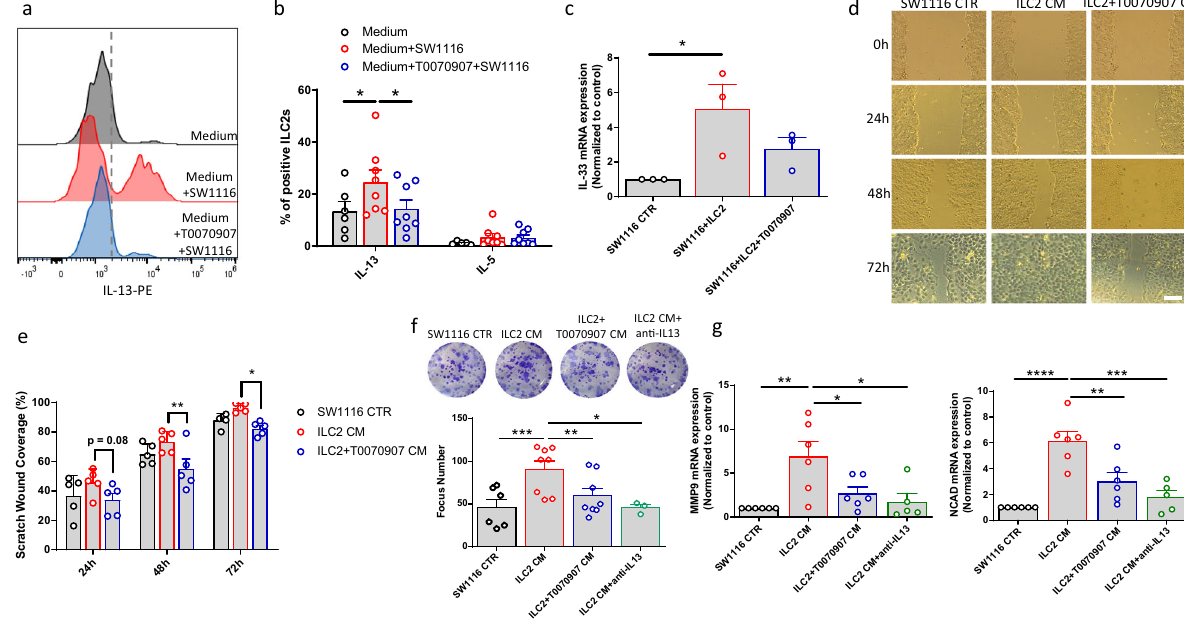
Fig. 5 IL-13 drives the crosstalk between ILC2s and cancer cells. a Representative example of fl ow cytometry analysis of ILC2-derived IL-13 upon co- culture with SW1116 CRC cells. b Frequencies of IL-13 and IL-5 positive ILC2s with T0070907 upon co-culture with SW1116 CRC cells ((Medium (open circle) Medium + SW1116 (open red circle) Medium + T0070907 + SW1116 (open blue circle)) (Medium n = 6, Medium + SW1116 n = 8, Medium + T0070907 + SW1116 n = 8; Medium vs Medium + SW1116 * P = 0.0313, Medium + SW1116 vs Medium + T0070907 + SW1116 * P = 0.0103). c Expression of IL-33 assessed by qPCR analysis in SW1116 CRC cells upon co-culture with ILC2s (SW1116 CTR (open circle) SW1116 + ILC2 (open red circle) SW1116 + ILC2 + T0070907 (open blue circle) ( n = 3; * P = 0.0419). d Representative example of a wound healing assay (×20 magni fi cation; Scale bar: 50 µ m) performed using SW1116 CRC cells (CTR (open circle)) after incubation with ILC2 (open red circle) or ILC2 + T0070907 conditioned medium (CM) (open blue circle). e Quanti fi cation of the healed wound area at 24, 48, and 72 h ( n = 5; ** P = 0.0078, * P = 0.0493). f Representative example and quanti fi cation of clonogenic assays performed using SW1116 CRC cells (open circle) after incubation with ILC2 CM (open red circle), ILC2 + T0070907 CM (open blue circle) or ILC2 CM + anti-IL-13 blocking antibody (open green circle) for 14 days (SW1116 CTR n = 6, ILC2 CM and ILC2 + T0070907 CM n = 8, ILC2 CM + anti-IL13 n = 3; *** P = 0.0002, ** P = 0.0085, * P = 0.0497). g Expression of MMP9 (left) and N-cadherin (right) assessed by qPCR analysis in SW1116 CRC cells (open circle) upon incubation with ILC2 CM (open red circle), ILC2 + T0070907 CM (open blue circle) or ILC2 CM + anti-IL- 13 blocking antibody (open green circle) (SW1116 CTR, ILC2 CM, ILC2 + T0070907 CM n = 6, ILC2 CM + anti-IL13 n = 5; MMP9 SW1116 CTR vs ILC2 CM ** P = 0.0035, ILC2 CM vs ILC2 + T0070907 CM * P = 0.0425, ILC2 CM vs ILC2 CM + anti-IL13 * P = 0.0152; NCAD SW1116 CTR vs ILC2 CM **** P < 0.0001, ILC2 CM vs ILC2 + T0070907 CM ** P = 0.0041, ILC2 CM vs ILC2 CM + anti-IL13 *** P = 0.0002). Each symbol represents one individual donor or sample. Data are shown as mean ± SEM and were analyzed by one- ( c , f , g ) or two-way ( b , e ) ANOVA tests. Source data are provided as a Source data fi